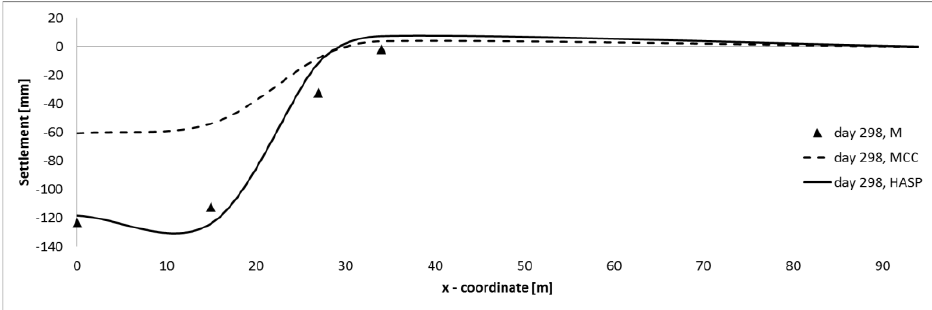
Figure 23. Comparison of the settlement of the ground surface for Embankment B — day 298.